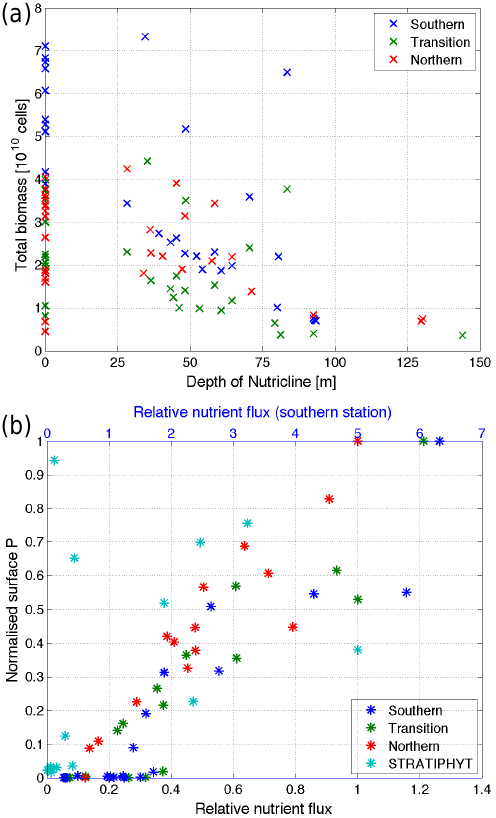
Figure 13. (a) The total biomass integrated over the water column Fig. 13: (a) The total biomass integrated over the water col- as a function of the depth of the nutricline. (b) Normalised sur- umn as a function of the depth of the nutricline. (b) Nor- face phytoplankton concentration vs. the relative nutrient flux for malised surface phytoplankton concentration vs. the relative the three reference stations and the measured STRATIPHYT data. For the modelled data only the nutrient-limited states are taken into nutrient flux for the three reference stations and the measured STRATIPHYT data. For the modeled data only the nutrient limited states are taken into account.